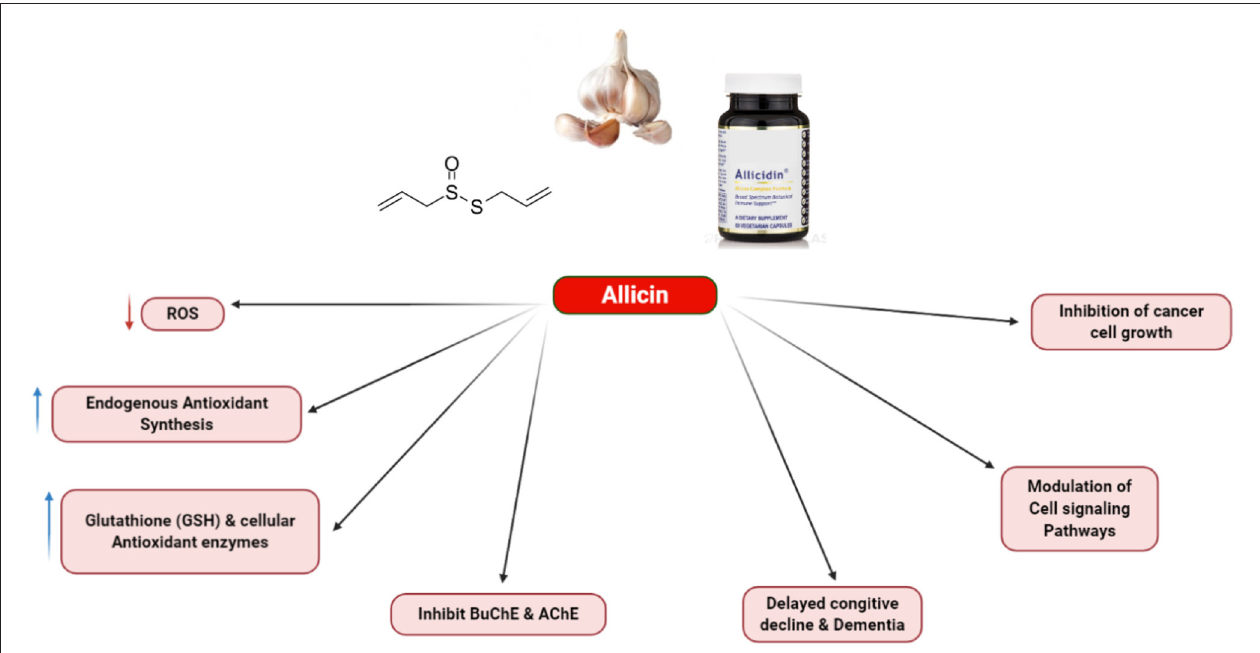
FIGURE 4 | Various biological action of